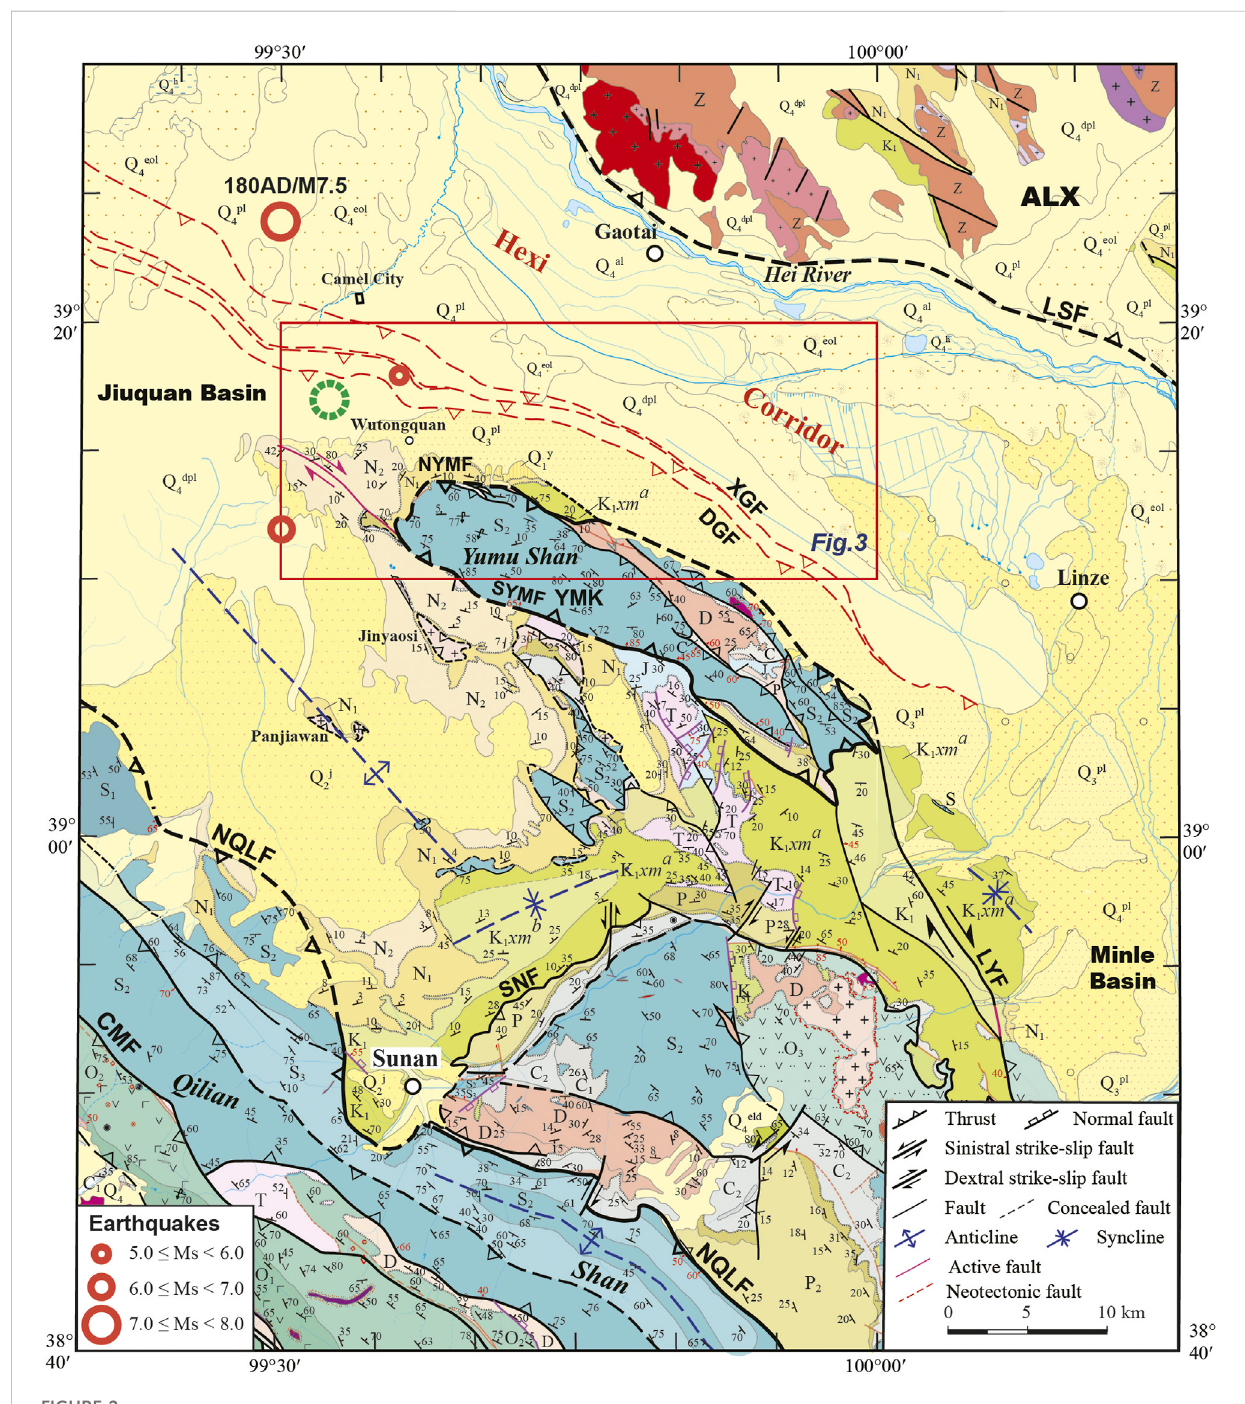
FIGURE 2 Geological map of the Yumu Shan and surrounding region in northern Qilian Shan and Hexi Corridor, modi fi ed from Chen et al. (2019b) and Wang et al. (2022). Locations of earthquake events are from Ren et al. (2019). The green dashed circle shows our suggested location for the 180AD/ Ms7.5 Biaoshi earthquake. ALX, Alxa block. Q h , Holocene. Q p , Pleistocene. N 2 , Pliocene. N 1 , Miocene. E, Paleogene. K 1 , Lower Cretaceous. J, Jurassic. T, Triassic.P,Permian.C 2 andC 1 ,UpperandLowerCarboniferous.D,Devonian.S 3 ,S 2 ,andS 1 ,Upper,Middle,andLowerSilurian.O 3 ,O 2 ,andO 1 ,Upper, Middle, and Lower Ordovician. CMF, Changma Fault. NQLF, North Qilian Fault. NYMF, North Yumu Shan Fault. SYMF, South Yumu Shan Fault.